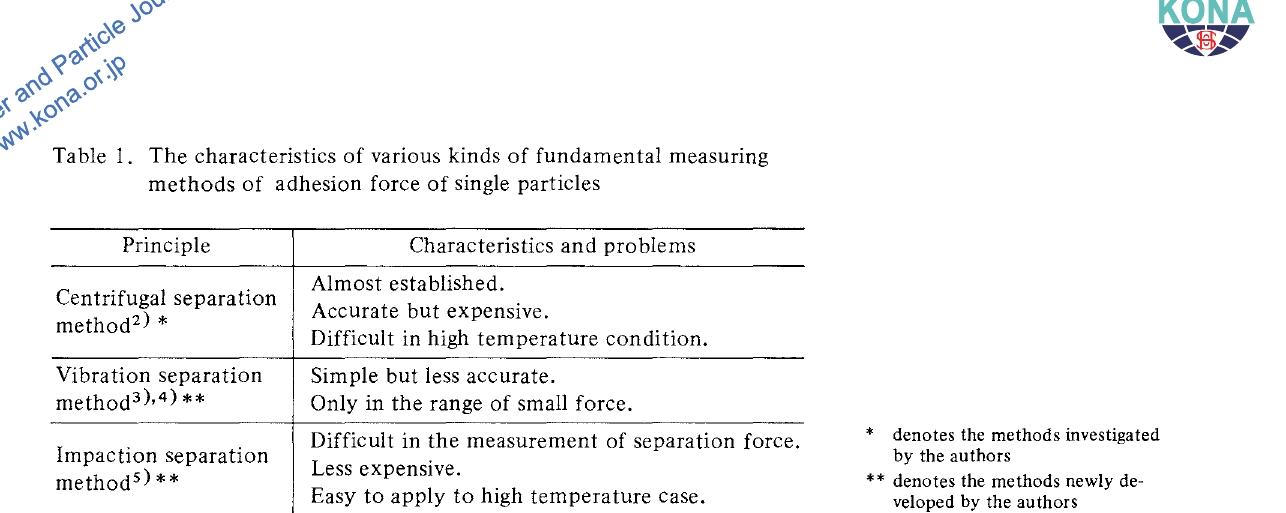
Table I. The characteristics of various kinds of fundamental measuring methods of adhesion force of single particles